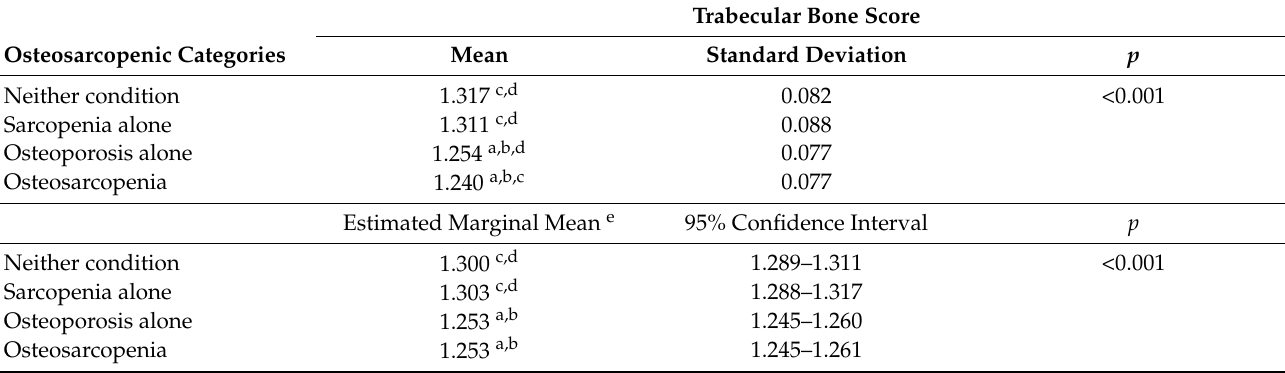
Table 5. Trabecular bone score according to osteosarcopenic categories, in which the “osteo” component included high-risk osteopenia ( − 2.5 SD < T-score < − 1 SD) and osteoporosis (T-score ≤ − 2.5